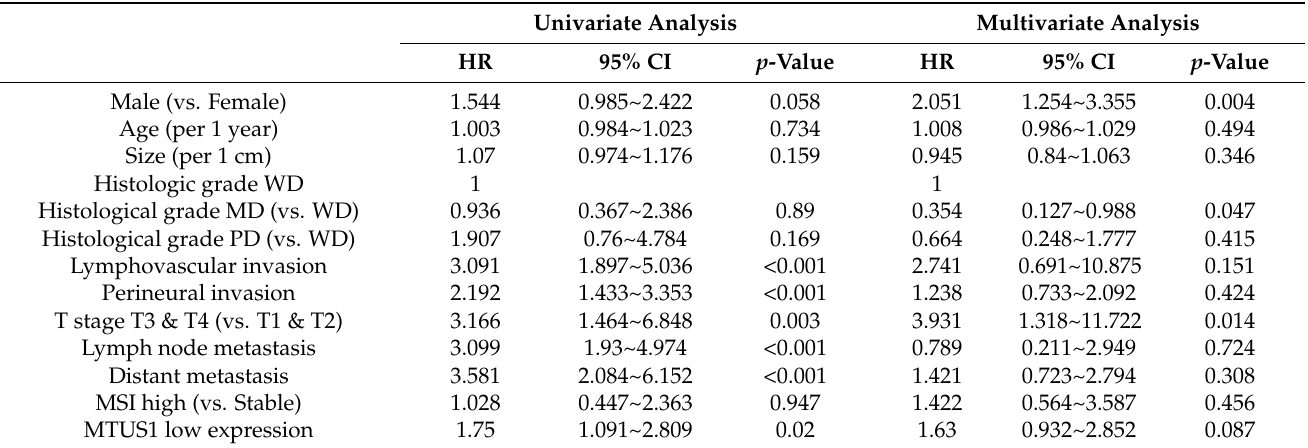
Table 4. Univariate and multivariate Cox regression analysis for recurrence-free survival in patients with colorectal adenocarcinoma ( n =